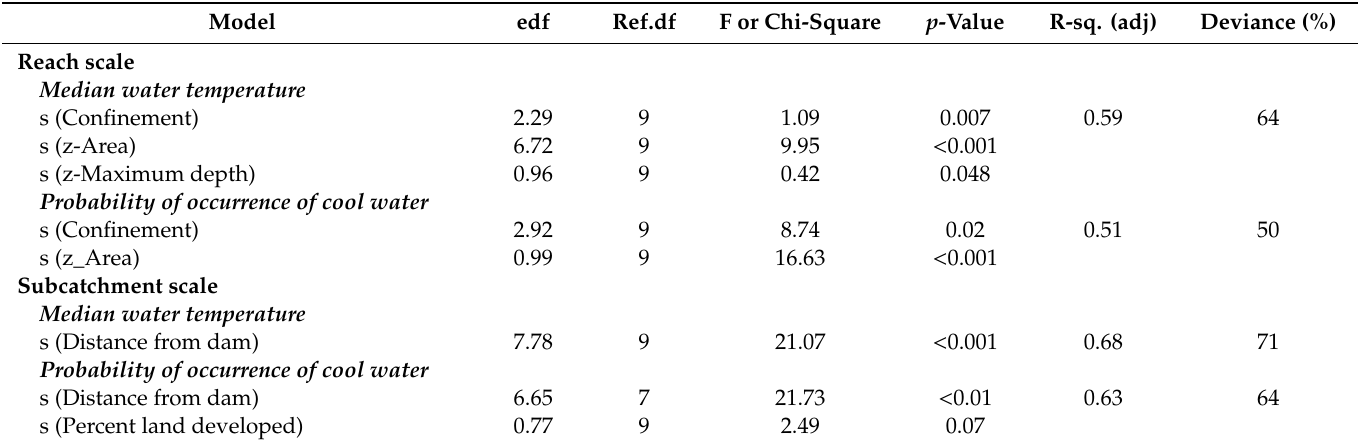
Table 6. Best generalized additive models for reach and subcatchment scales for each response variable, median water temperature, and probability of occurrence. E ff ective degrees of freedom (edf), reference degrees of freedom (Ref.df), F-values for the Gaussian distribution models, and chi-square values for the binomial distribution models, p -values, adjusted R-squared, and percent deviance explained by